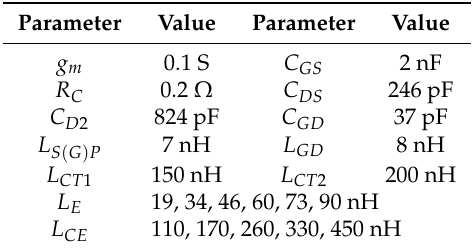
Table 2. Parameters for the